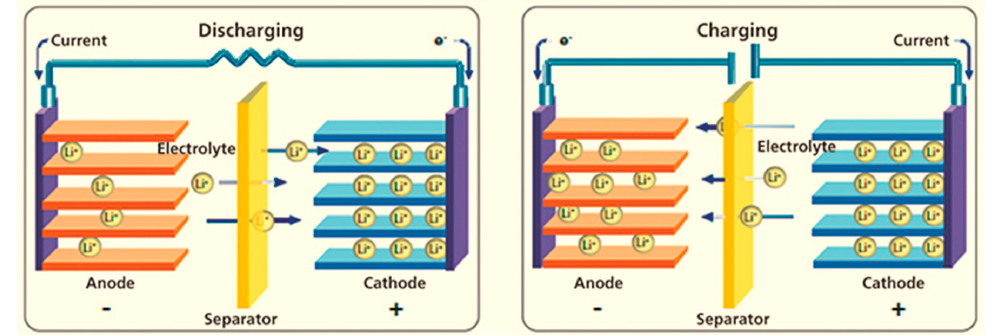
Figure 1. Basic working principle of a lithium-ion (Li-ion) battery [1].